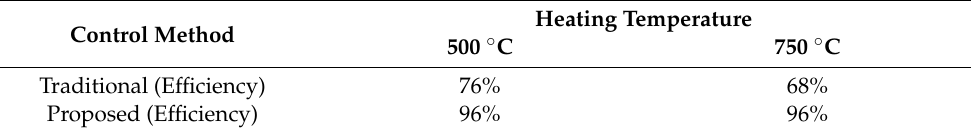
Table 6. Performance comparison between the traditional heating control strategy and the proposed MPPT heating control